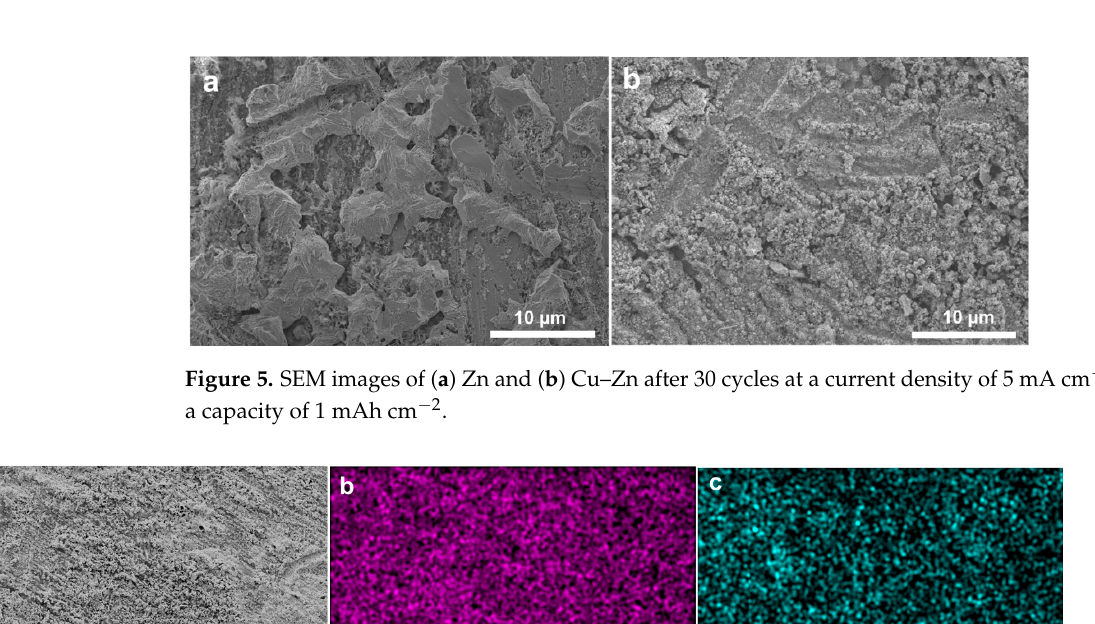
Figure 6. ( a ) SEM image and ( b , c ) corresponding elemental mappings of Cu–Zn after 50 cycles at current density of 5 mA cm − 2 with a capacity of 1 mAh cm − 2 .